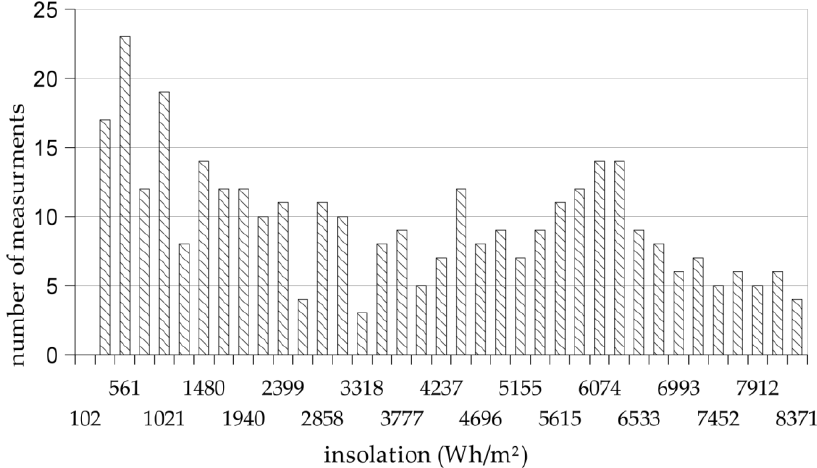
Figure 2. Distribution of measurement points in the temperature set T.